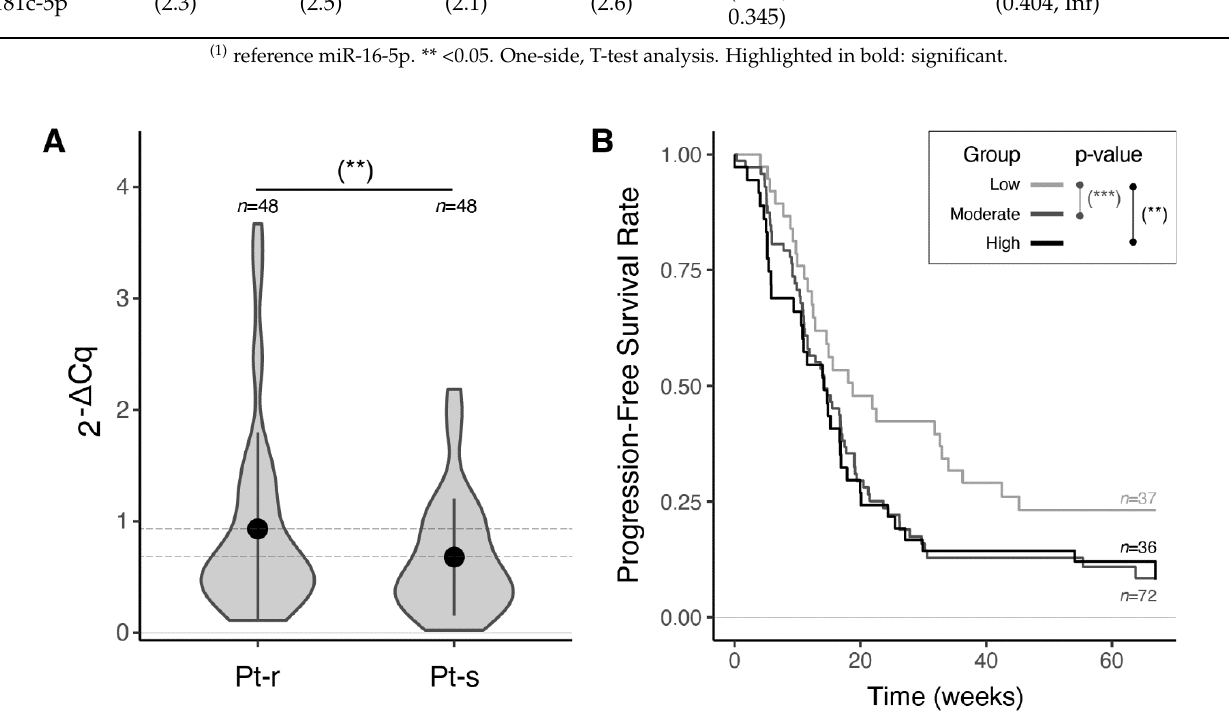
Table 4. Differential expression analysis. The miR-23a-3p and miR-181c-5p expression in Pt-r ( n = 48) and Pt-s ( n = 48) patients evaluated by RT-qPCR (Brescia cohort).